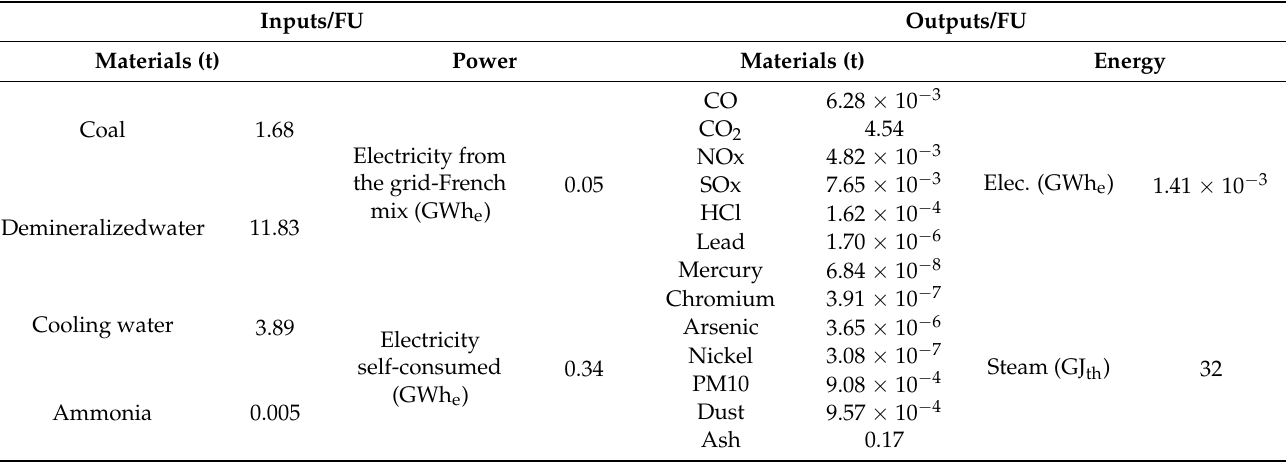
Table 4. Calculated inventory (main results) for the power plant (reference scenario).